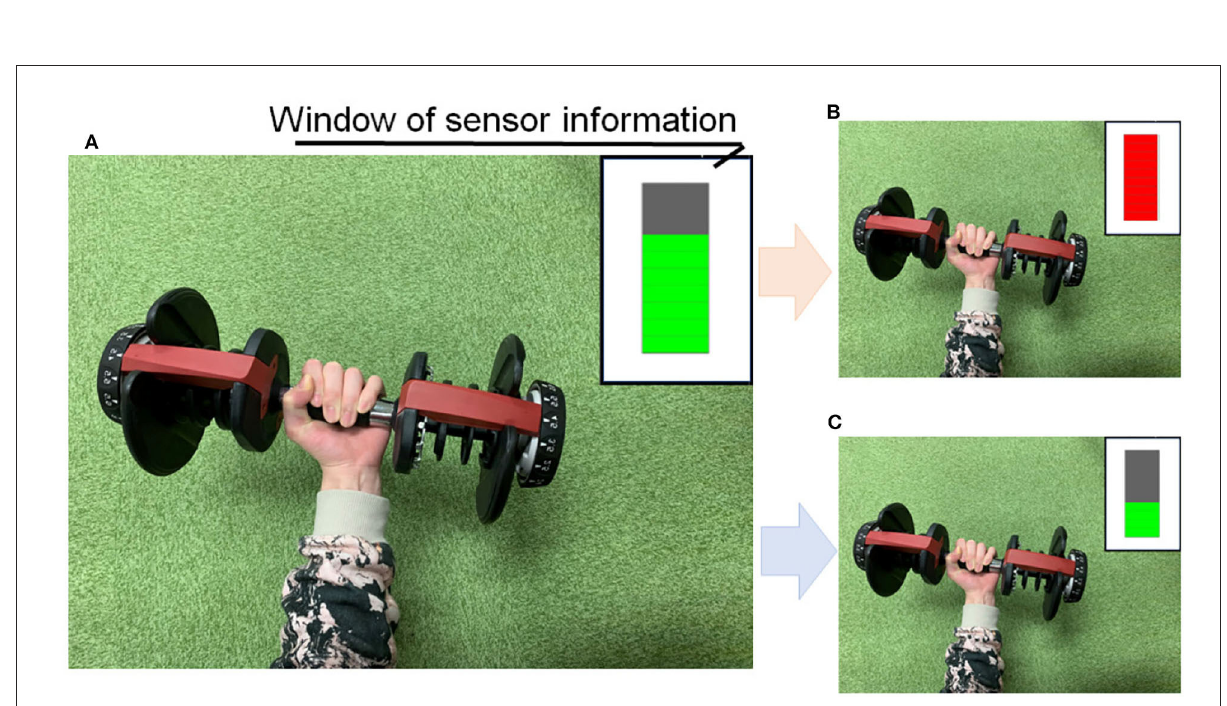
FIGURE2 Window design of sensor information. (A) Presenting myoelectricity sensor information, (B) presenting high load reproduction information, (C) presenting low load reproduction information (Futami et al.,